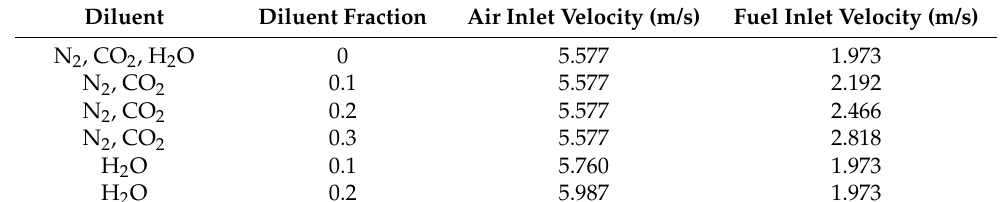
Table 1. Inlet boundary conditions.